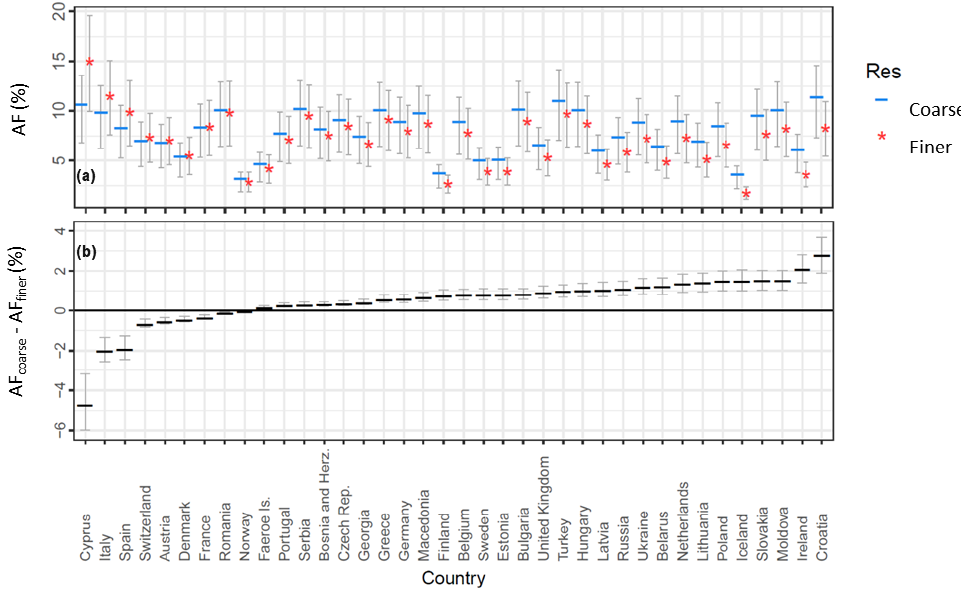
Figure 8. (a) AF associated with long-term exposure to PM 2 . 5 for each model resolution expressed as a percentage. (b) Differences in AF between the two resolutions expressed as a percentage for each European country (AF coarse − AF finer ). Grey lines show the 95% CI which represents uncertainties associated only with the concentration–response coefficient